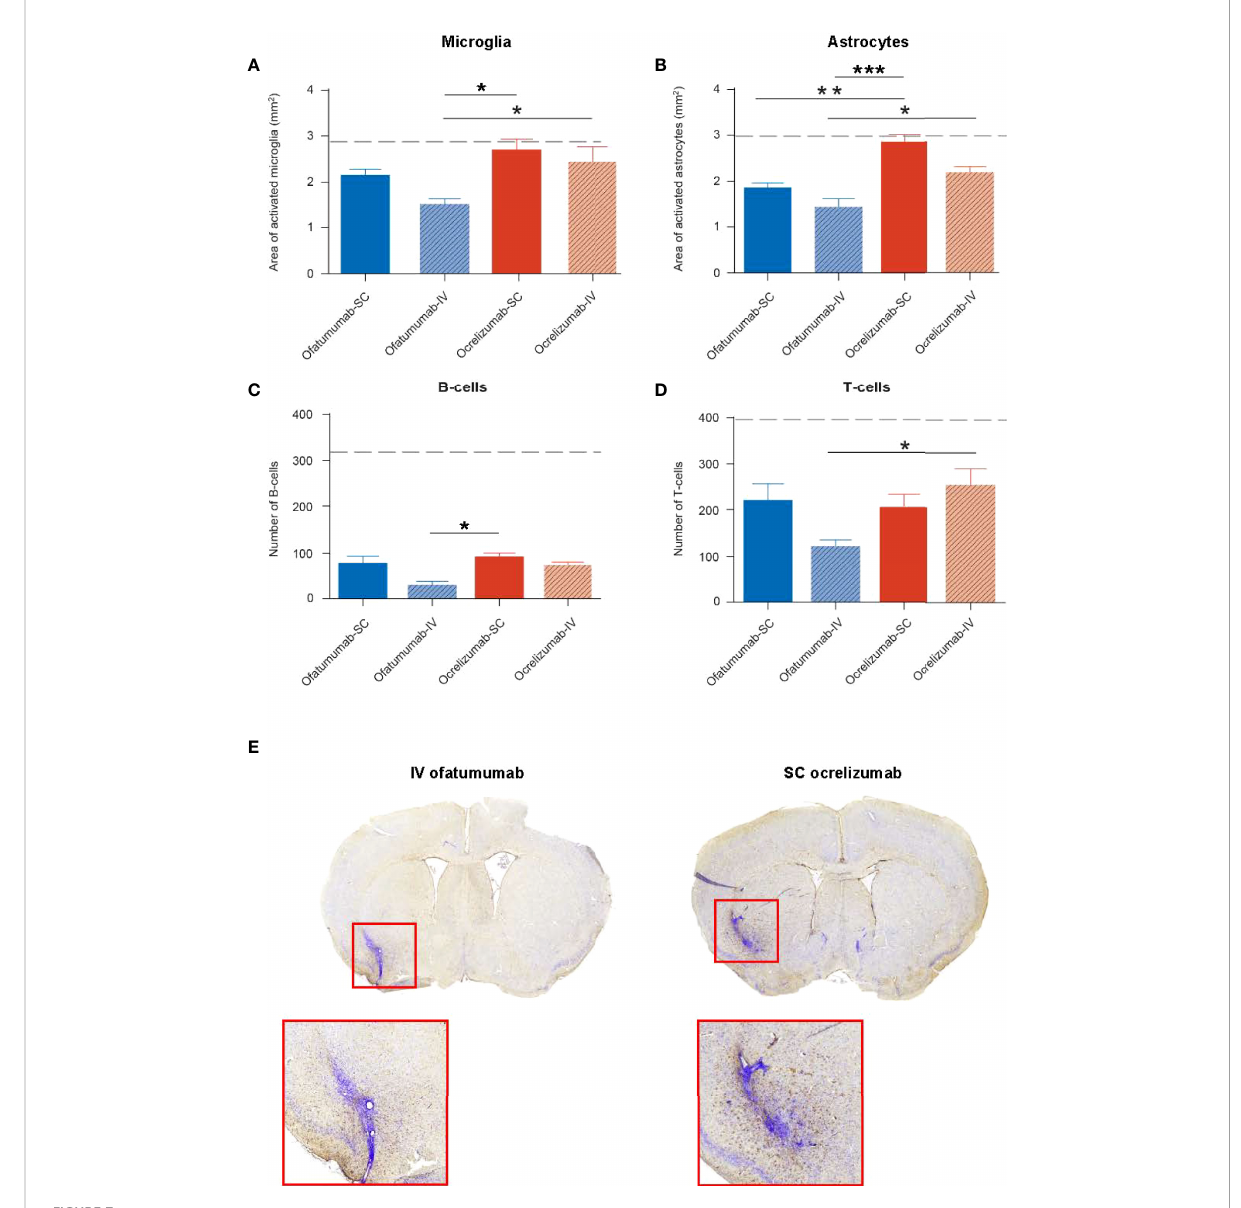
FIGURE 7 Two-way ANOVA revealed a signi fi cant effect of treatment on the area of microglia and astrocyte activation as well as the number of B- and T- cells in the lesion, as assessed by IHC. (A) The area of microglia activation was signi fi cantly reduced with IV ofatumumab versus IV and SC ocrelizumab. (B) The area of astrocyte reactivity was signi fi cantly reduced with IV and SC ofatumumab versus SC ocrelizumab, and by IV ofatumumab vs IV ocrelizumab. (C) IHC demonstrated a lower number of B-cells in the lesion of mice treated with IV ofatumumab compared with SC ocrelizumab. (D) IHC demonstrated a signi fi cant reduction in the number of T-cells with IV ofatumumab versus IV ocrelizumab. (E) Representative images of microglial activation in the brains of IV ofatumumab-treated mice (left) and SC ocrelizumab-treated mice (right) * p < 0.05, ** p < 0.01. Data represents mean ± SEM. Dashed line represents vehicle-treated animals (SEM: microglia, 0.286; astrocytes, 0.4656; B-cells, 86.58; T-cells,